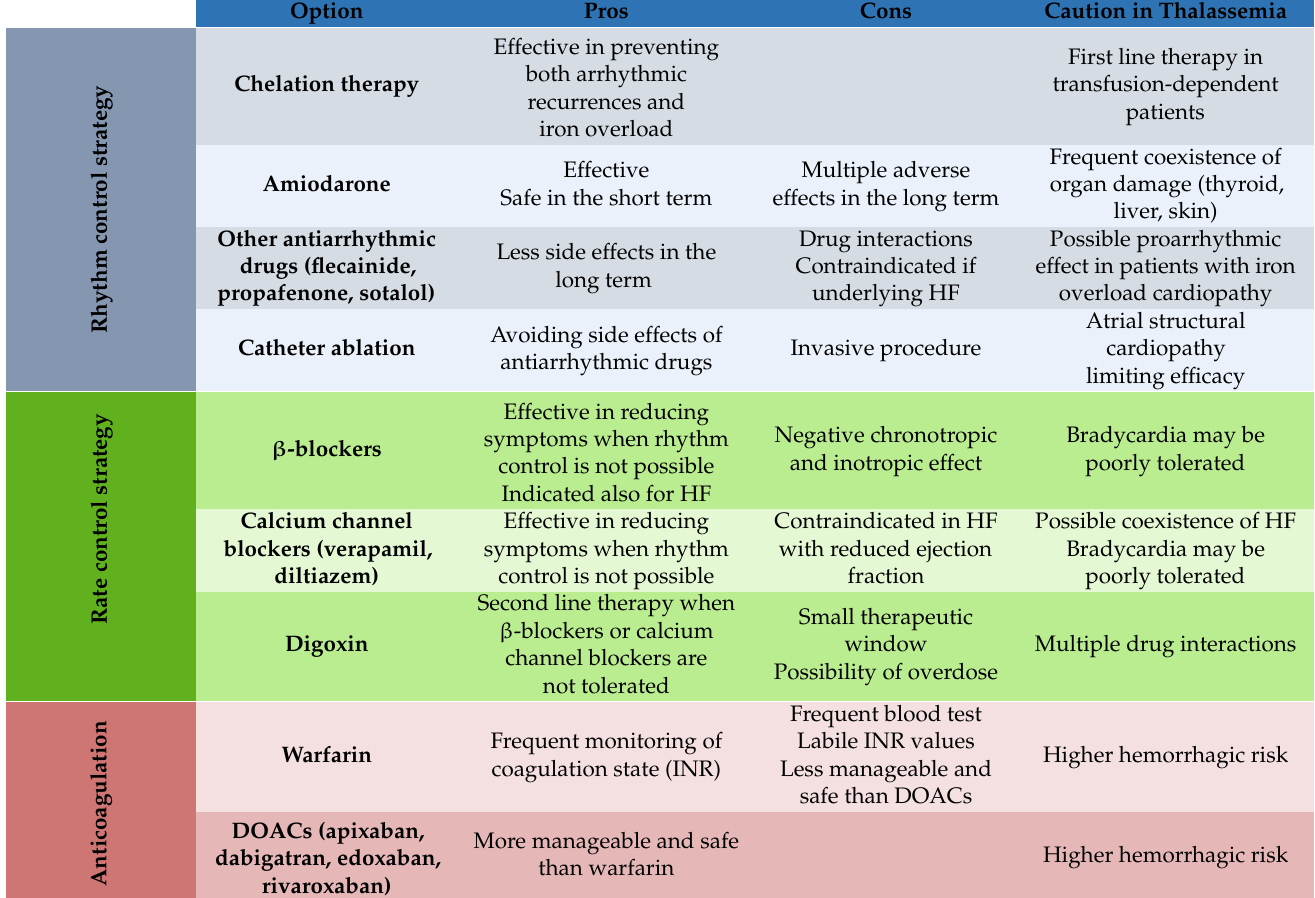
Table 1. Therapeutic options for the management of atrial fibrillation in patients with β